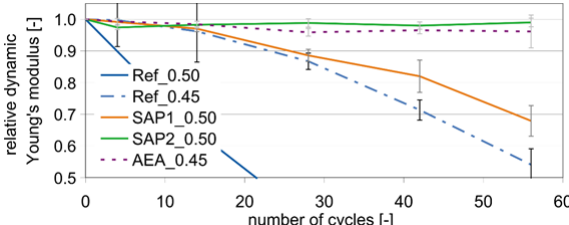
Figure 6. Changes in relative Young’s modulus during CIF test at the TU Dresden; numbers after_ give the total w/c of concrete; concrete with addition of SAP2 and w/c=0.50 shows a similar frost resistance as concrete with air entrainment agent (AEA) and w/c=0.45.